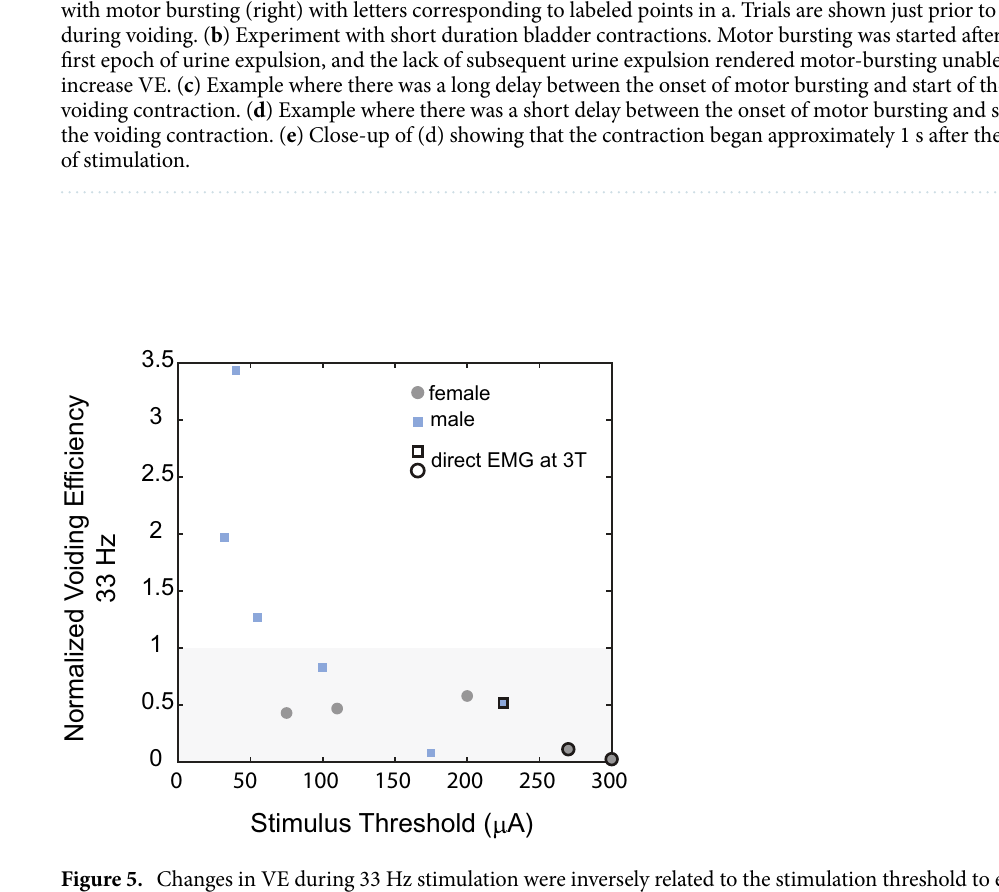
Figure 5. Changes in VE during 33 Hz stimulation were inversely related to the stimulation threshold to evoke reflex EMG activity. In some cases stimulation testing, which was always conducted at 3 times threshold (3 T), led to direct (< 1 ms latency) external anal sphincter (EAS) EMG activation (indicated by outlines around